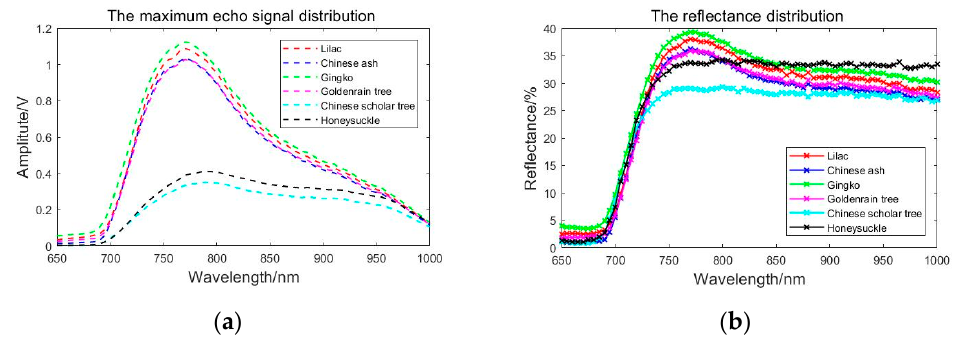
Figure 2. The distribution of features. ( a ) Echo maximum and ( b ) reflectance.